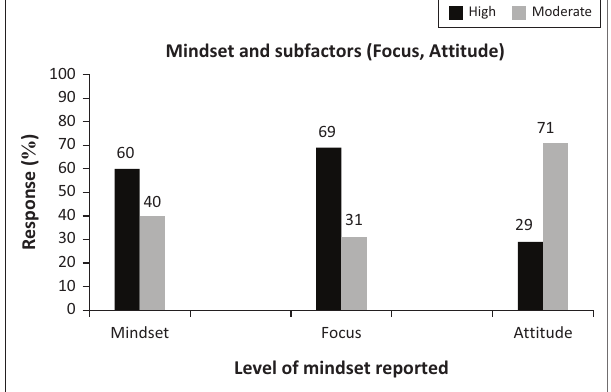
FIGURE 2: First responder mindset.